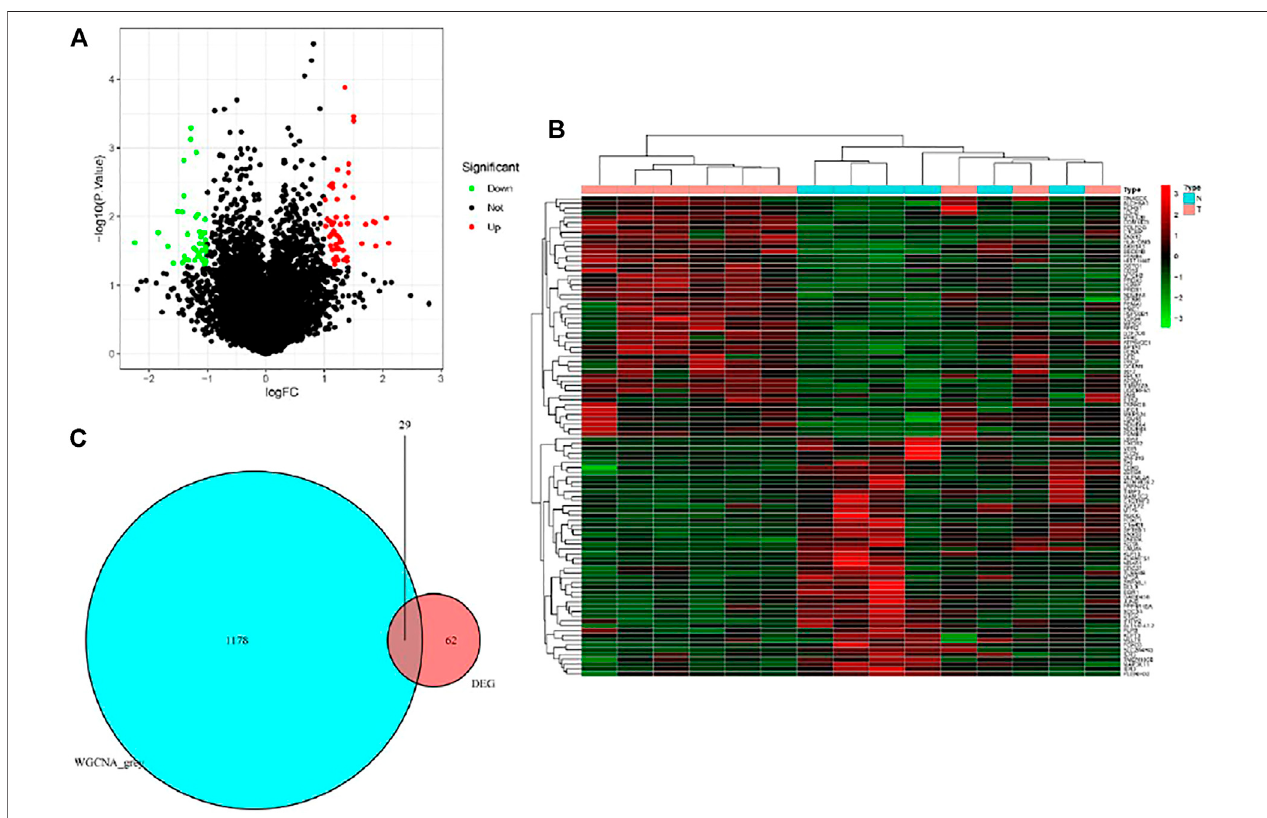
FIGURE3| Identi fi cationofdifferentiallyexpressedgenes(DEGs)inthedatasetswiththecut-offcriteriaof|logFC| ≥ 1.0and p < 0.05. (A) VolcanoplotofDEGs. (B) Heatmap of DEGs. (C) The Venn diagram of genes among DEG list and co-expression module. In total, 29 overlapping genes in the intersection of DEG lists and co- expression